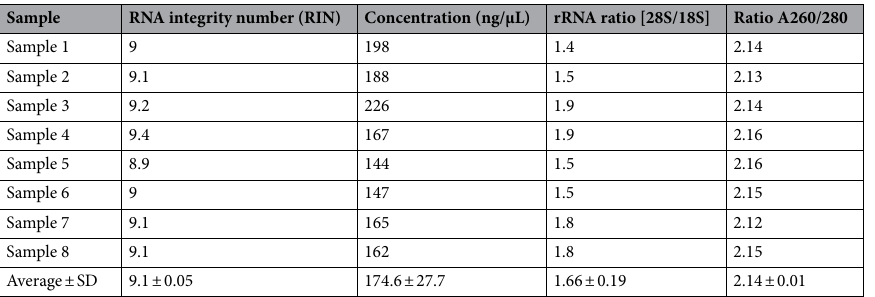
Table 1. RNA extraction from mouse tissue resulted in high-integrity, highly-concentrated total